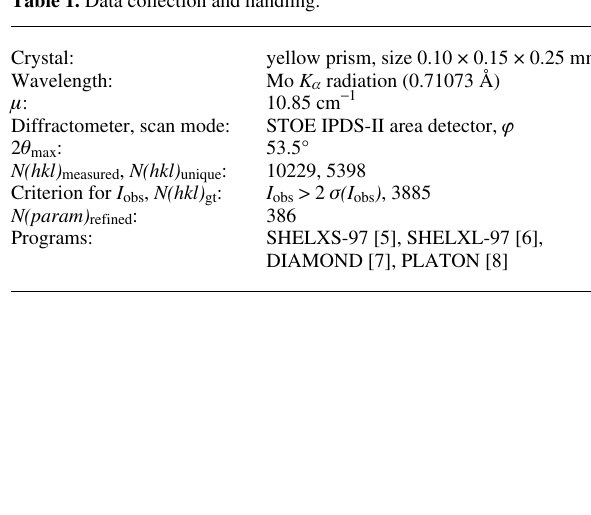
Table 2. Atomic coordinates and displacement parameters (in Å 2 ) . Table 1. Data collection and